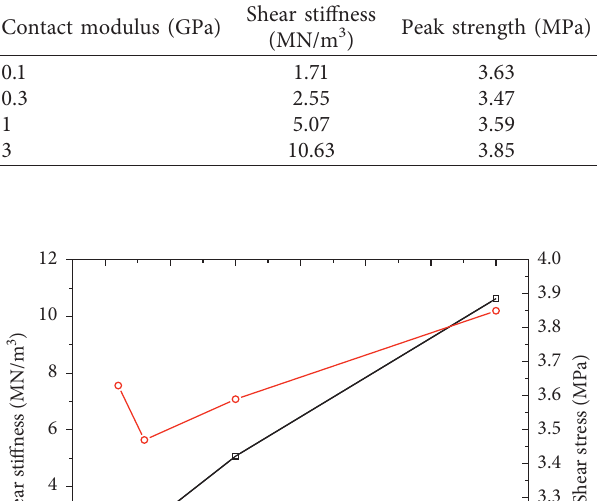
Figure 2: Shear stress deformation curves of bolted joints under different contact modulus.